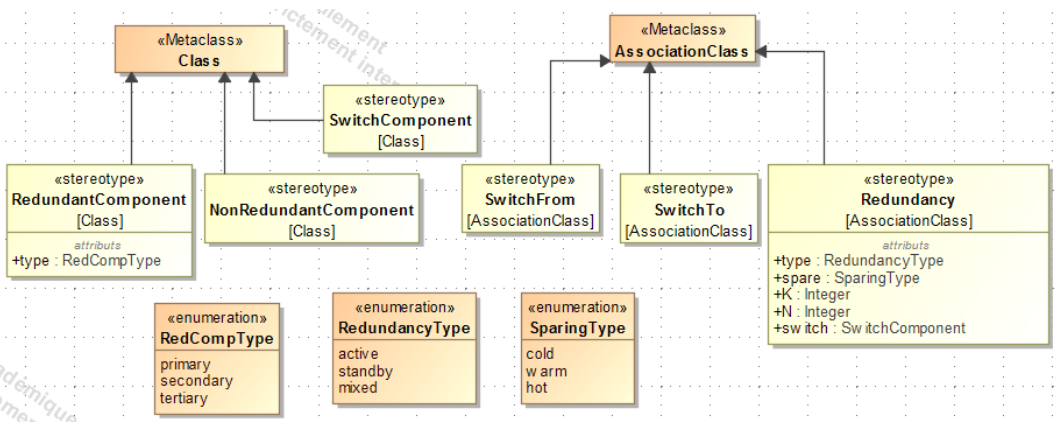
Figure 3. Profile